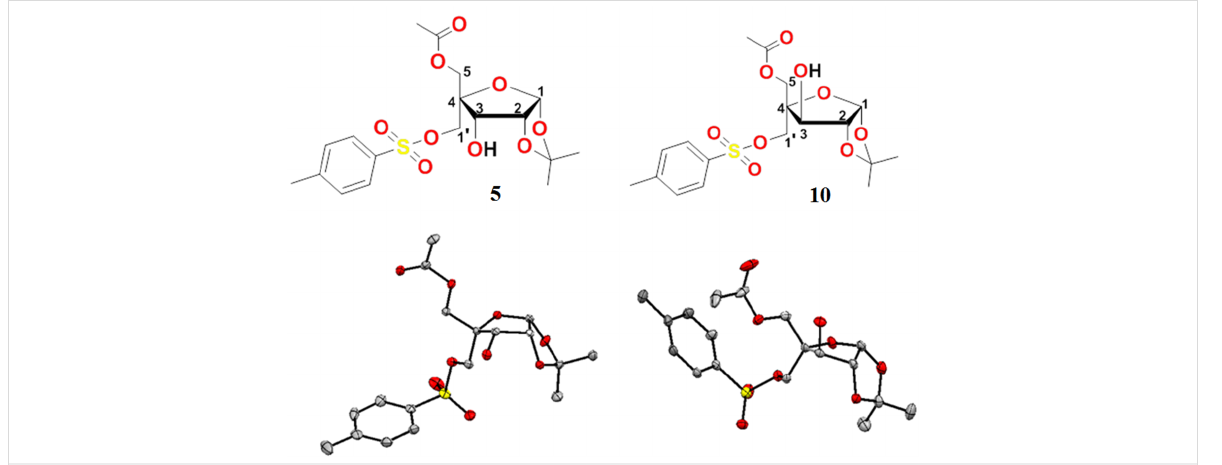
Figure 2: ORTEP diagram of tosylated sugar derivatives 5 and 10 .